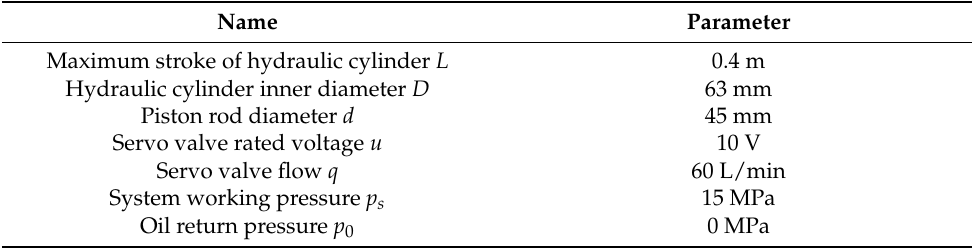
Table 1. Parameters of electro-hydraulic position servo system.